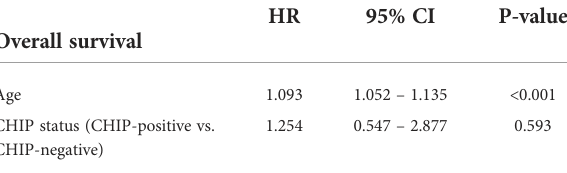
TABLE 2 Cox proportional regression with age and CHIP status included as